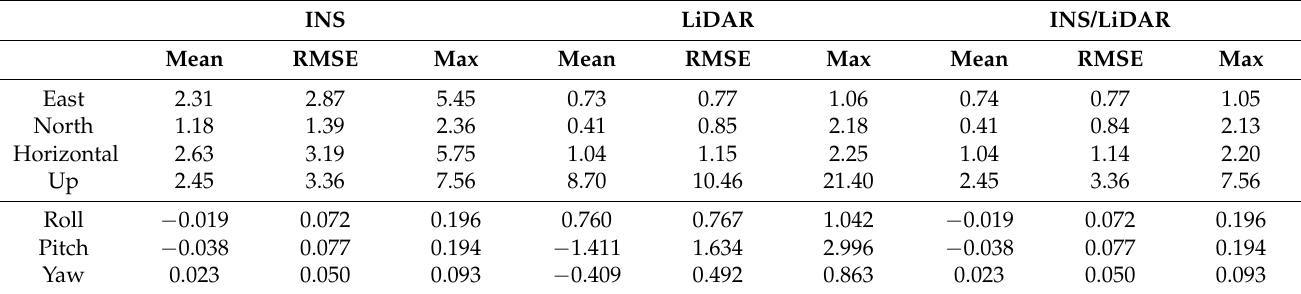
Table A23. D-32—position (m) and attitude (deg) error